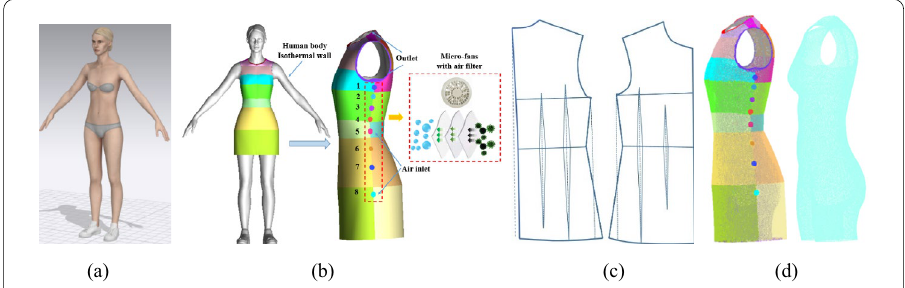
Fig. 1 3D model and boundary conditions. a Geometry model, b garment type and boundaries, c garment pattern, d mesh